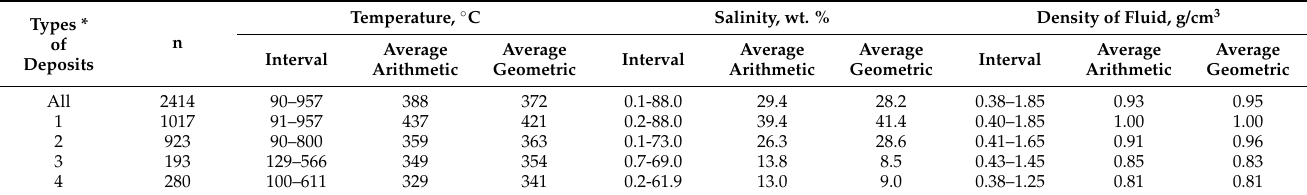
Table 3. Parameters of mineralizing fluids at porphyry deposits of different types.